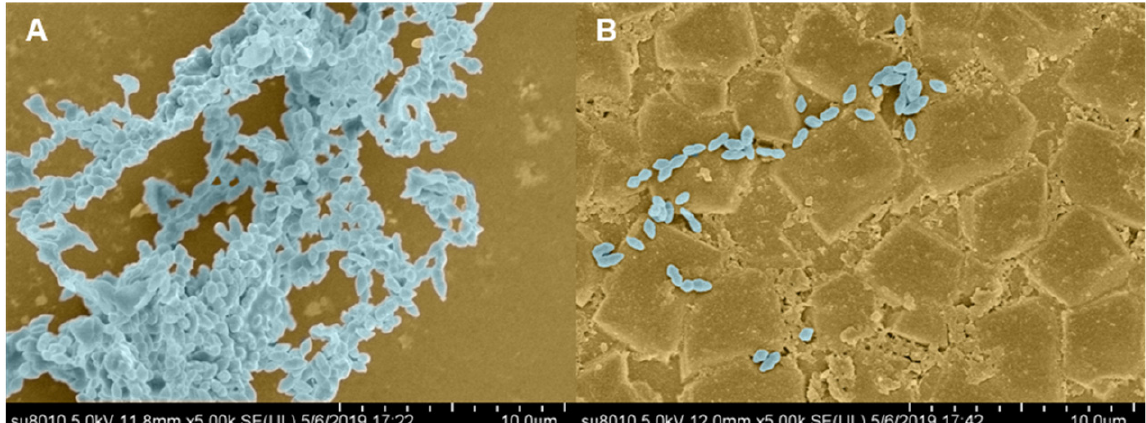
Figure 7. Scanning electron micrographs of Staphylococcus suis biofilm formation in the condition of no addition of syringopicroside ( A ) or treated with 1 / 2 minimum inhibition concentration (MIC) of syringopicroside ( B ) in Todd-Hewitt Broth (THB) culture medium.